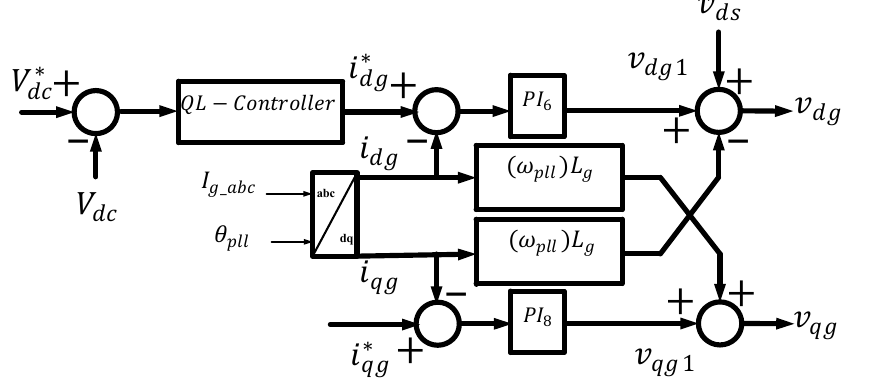
Figure 12. QL controller design on GSC.